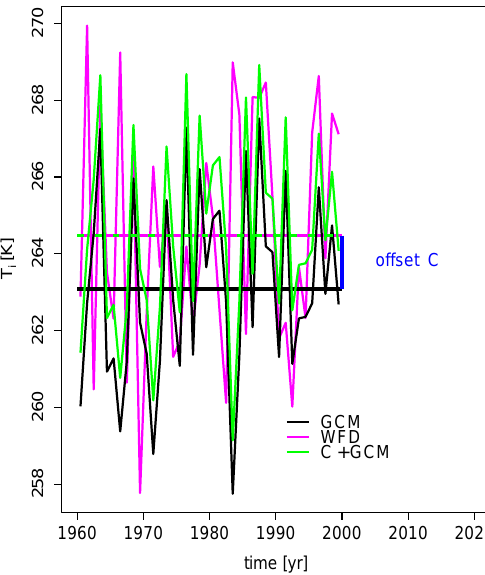
Fig. 2. April precipitation means for the example grid cell during the reference period. WFD (red), uncorrected (black) and scaled GCM (green) data are shown. The horizontal lines refer to the associated long-term